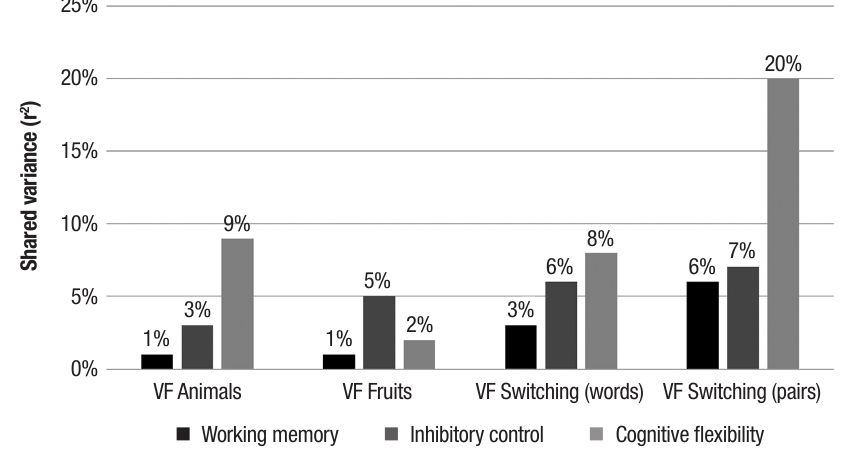
Figure 1. Shared variance between different verbal fluency tests and specific aspects of executive